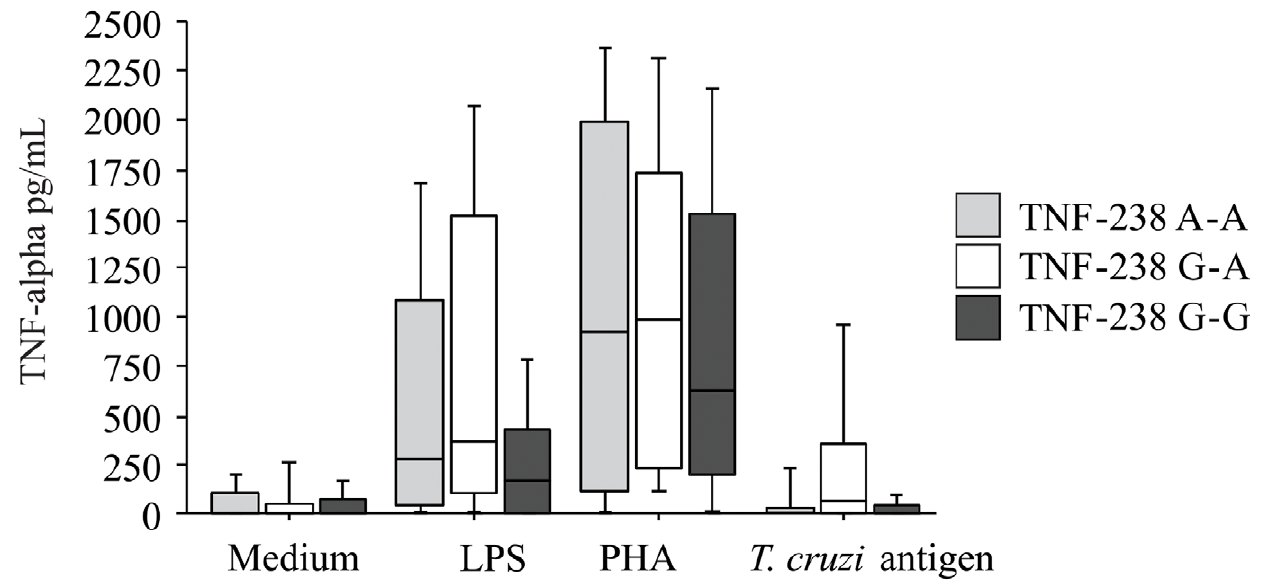
Figure 2. Levels of TNF-alpha in culture supernatants. TNF-alpha was assayed by ELISA in supernatants of PBMC cultured for 48 h in the absence of any stimulus and in the presence of T. cruzi antigen, LPS and PHA. Subjects were grouped according to TNF-238A genotypes (TNF-238AA, TNF-238GA and TNF-238GG). Individuals with positive and negative serology were analyzed. Results are expressed as pg/mL. The horizontal line indicates the median, bars the 25% and 75% percentiles, and vertical lines the 10% and 90%